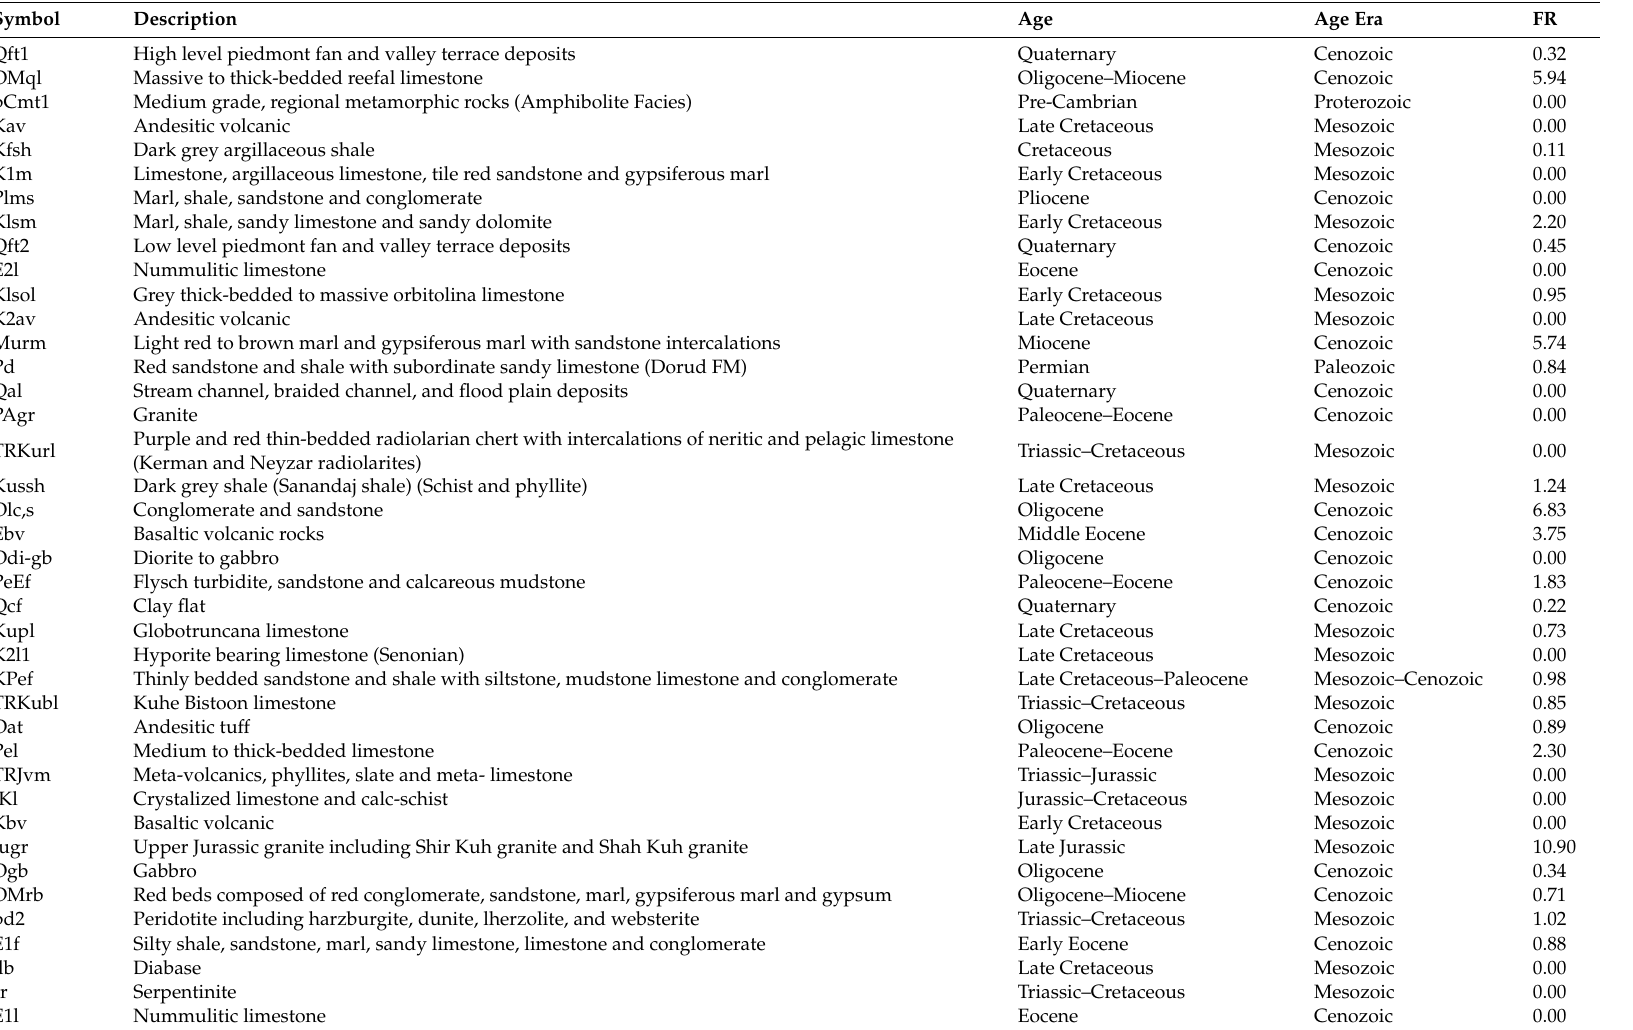
Table 1. Description of the lithology